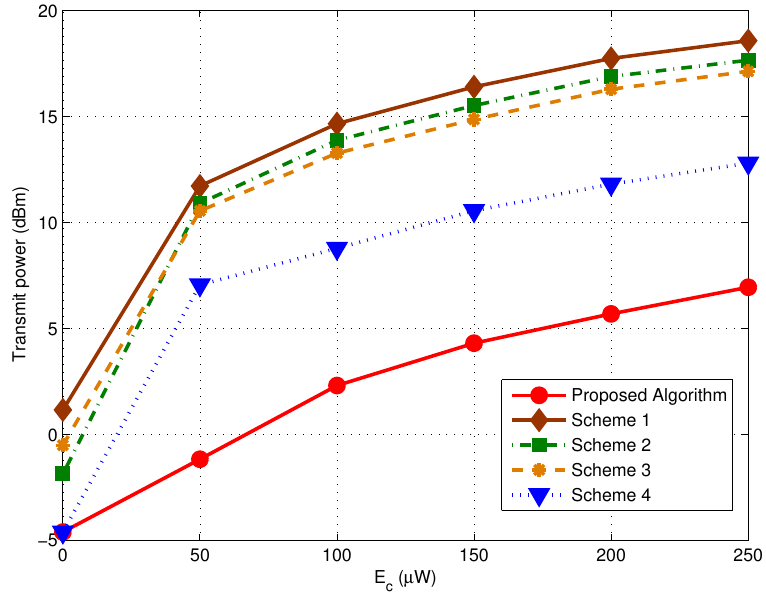
Figure 4. Transmit Power versus the harvest energy E c for the proposed algorithm ( σ 2 = − 112 dBm and K = 12, the BER target is 10 − 5 for each